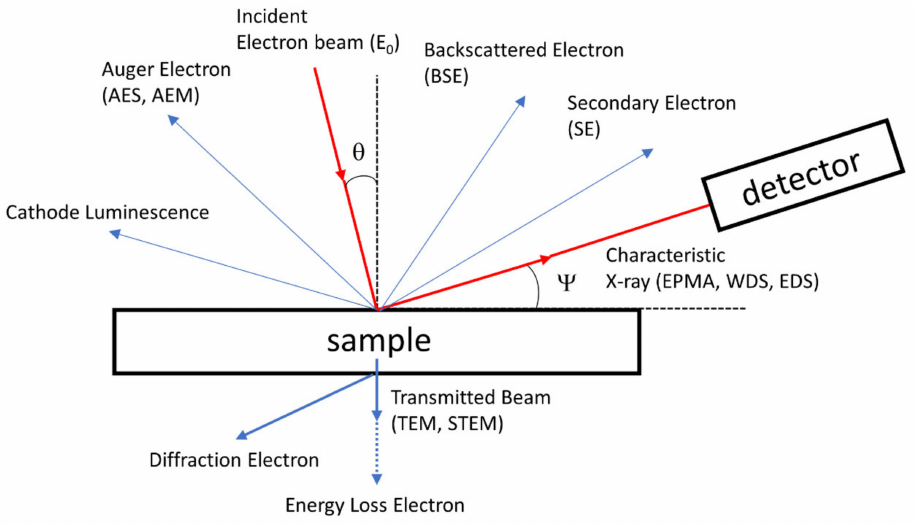
Figure 12. Possible routes for electron beam to interact with a sample and their